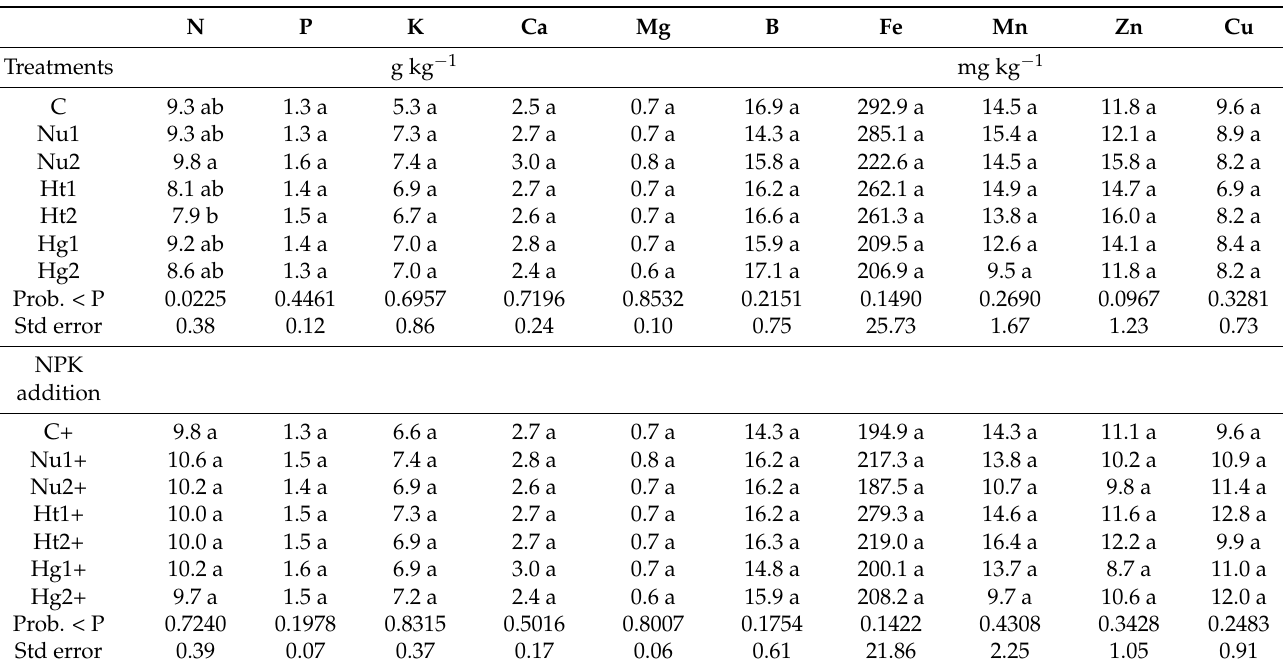
Table 3. Stem nutrient concentration in response to the application of organic amendments (C, Control; Nu, Nutrimais; Ht, Humitec; and Hg, Humic gold, applied at two rates (1,2)) in experiments without and with NPK(+) mineral fertilization. For each independent experiment, means followed by the same letter are not significantly different by Tukey HSD test ( α =